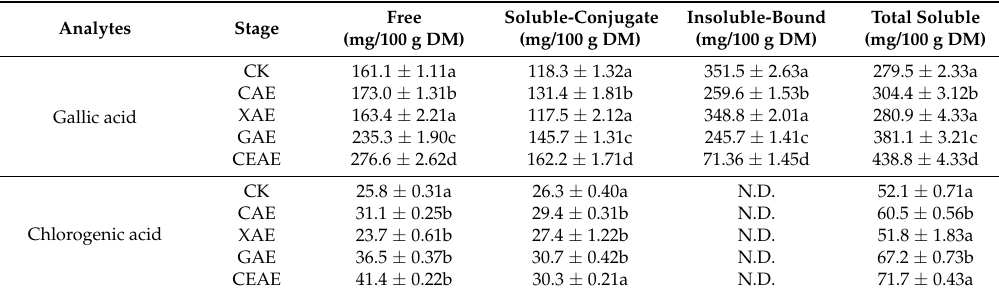
Table 1. Changes in individual phenolics in GL extract following enzymatic treatment of the free, soluble-conjugate, insoluble bound, and total soluble phenolics fractions. Analytes